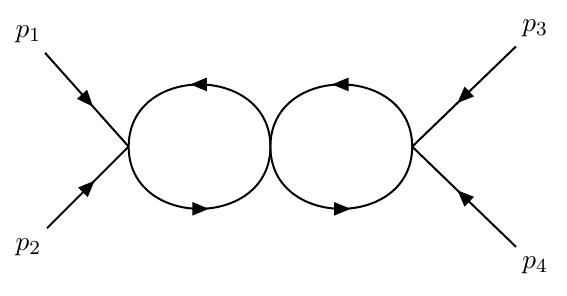
Figure 3 . Leading log two loop